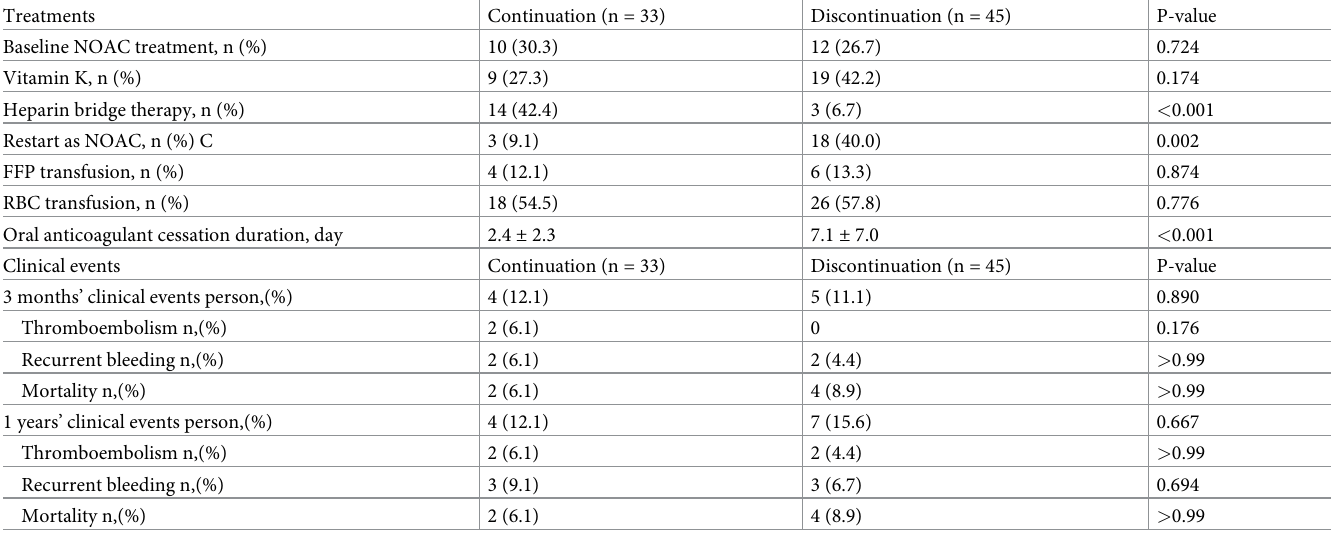
Table 4. Treatment strategies of patient group with high-risk thromboembolism and their